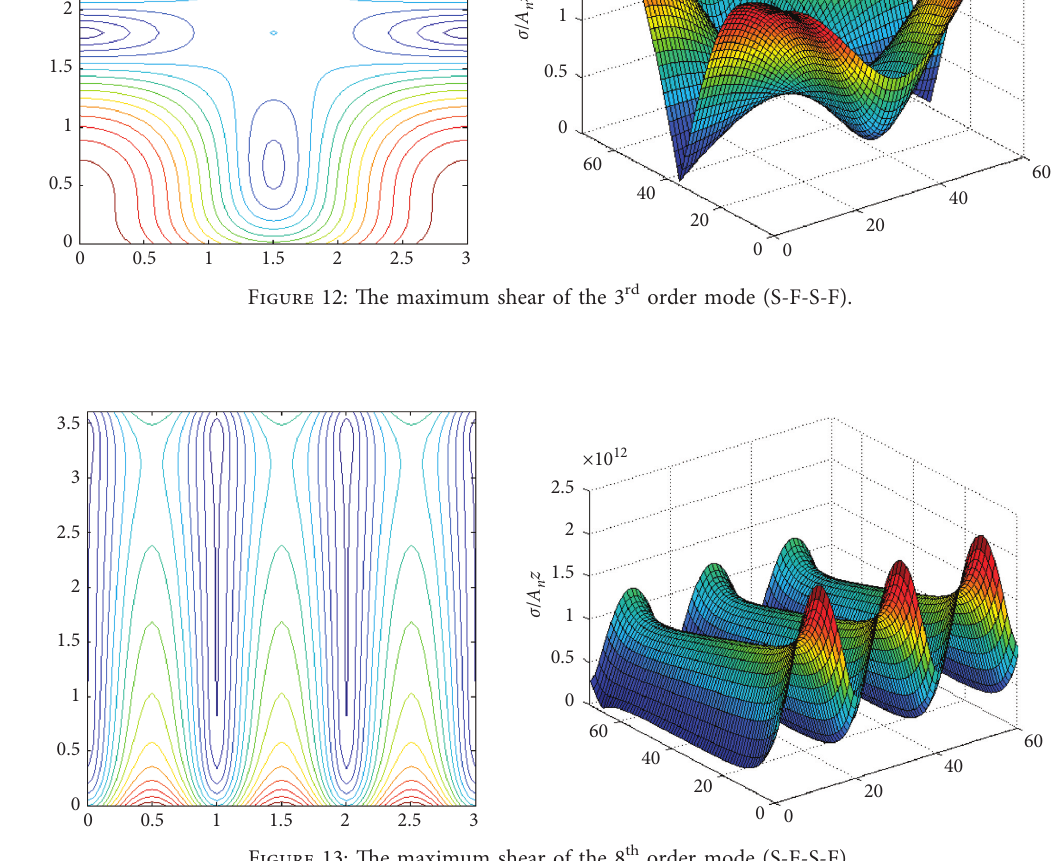
Figure 13: The maximum shear of the 8 th order mode (S-F-S-F).